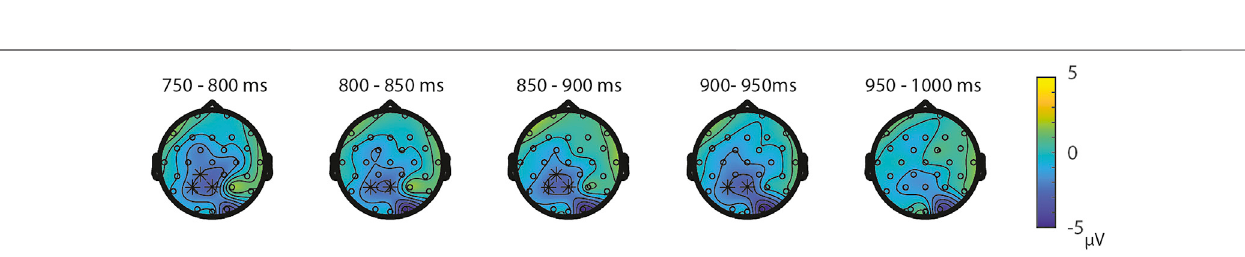
Frontiers in Education |